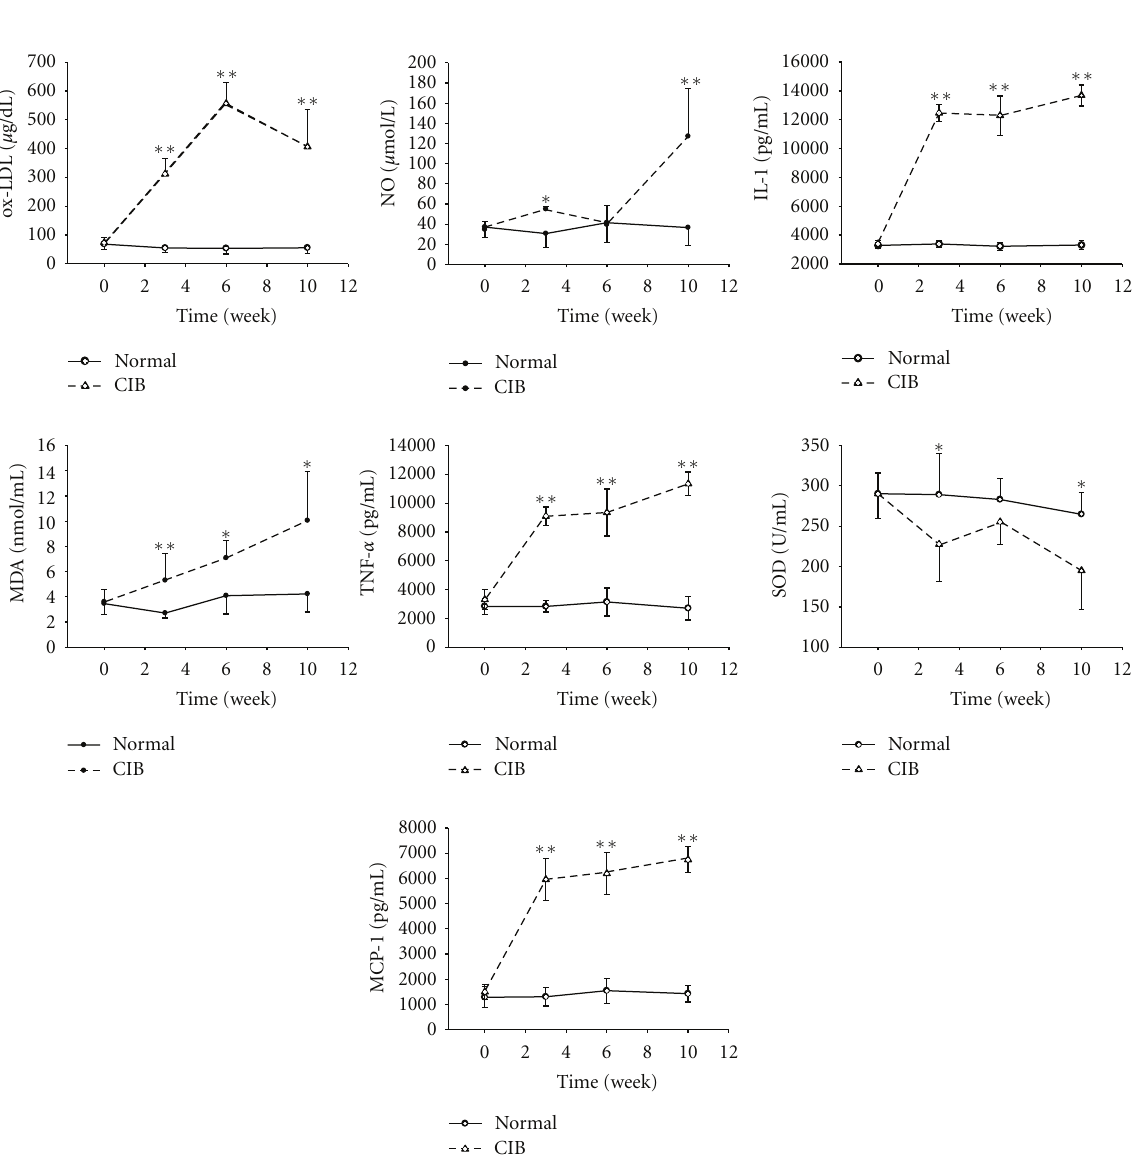
Figure 7: Analysis of biochemical measurements in two groups of rabbits. Serum level of IL-1, ox-LDL, NO, SOD, MDA, MCP-1, and TNF- α by using of enzyme-linked immunosorbent assay on week 0, 3, 6, 10. IL-1, interleukin-1; ox-LDL, oxidized LDL cholesterol; NO, nitric oxide; SOD, superoxide dismutase; MDA, malondialdehyde; MCP-1, monocyte chemoattractant protein-1; TNF- α , tumor necrosis factor- α . Data are expressed as mean ± SD, ∗ P < 0 . 05, ∗∗ P < 0 . 01 compared with normal